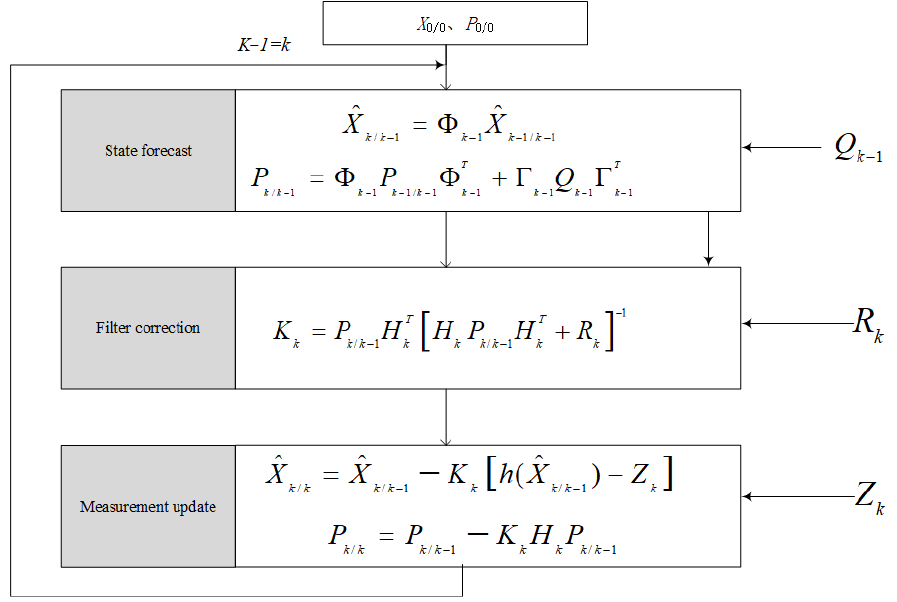
Figure 7. Workflow of Kalman filter.